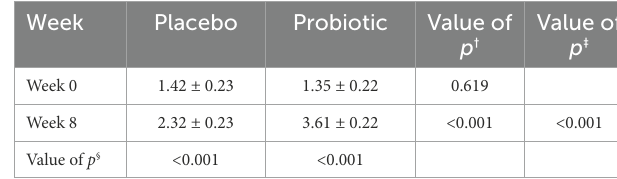
TABLE 3 Number of Weissella cibaria measured at 0 and 8 weeks (unit: log 10 DNA copy N).